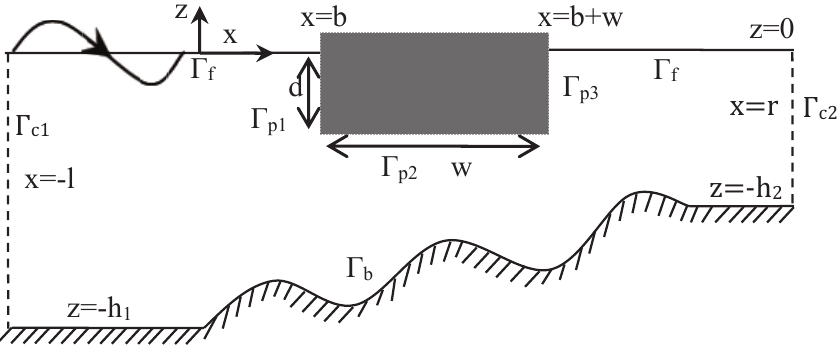
Figure 1. Vertical cross section of a rectangular buoy floating over an undulated